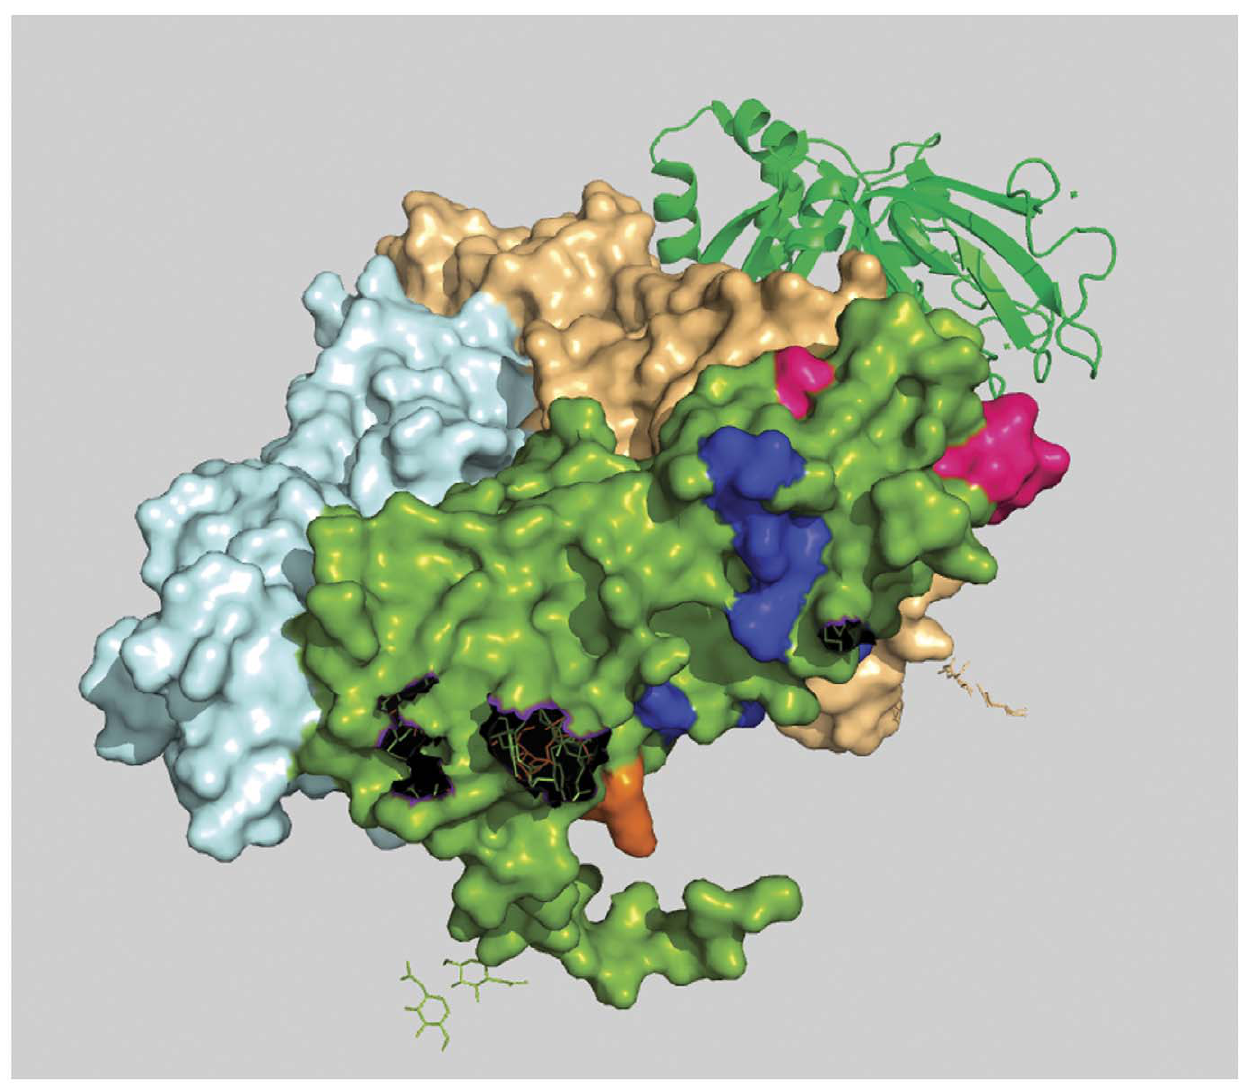
Figure 5. Position of Peptide-b is shown from outer surface of the virion in 3D-space filling model of rotaviral trimeric VP7. Peptide- b (aa 242 to aa 255) is shown in blue color and clearly highlights its discontinuous characteristic.